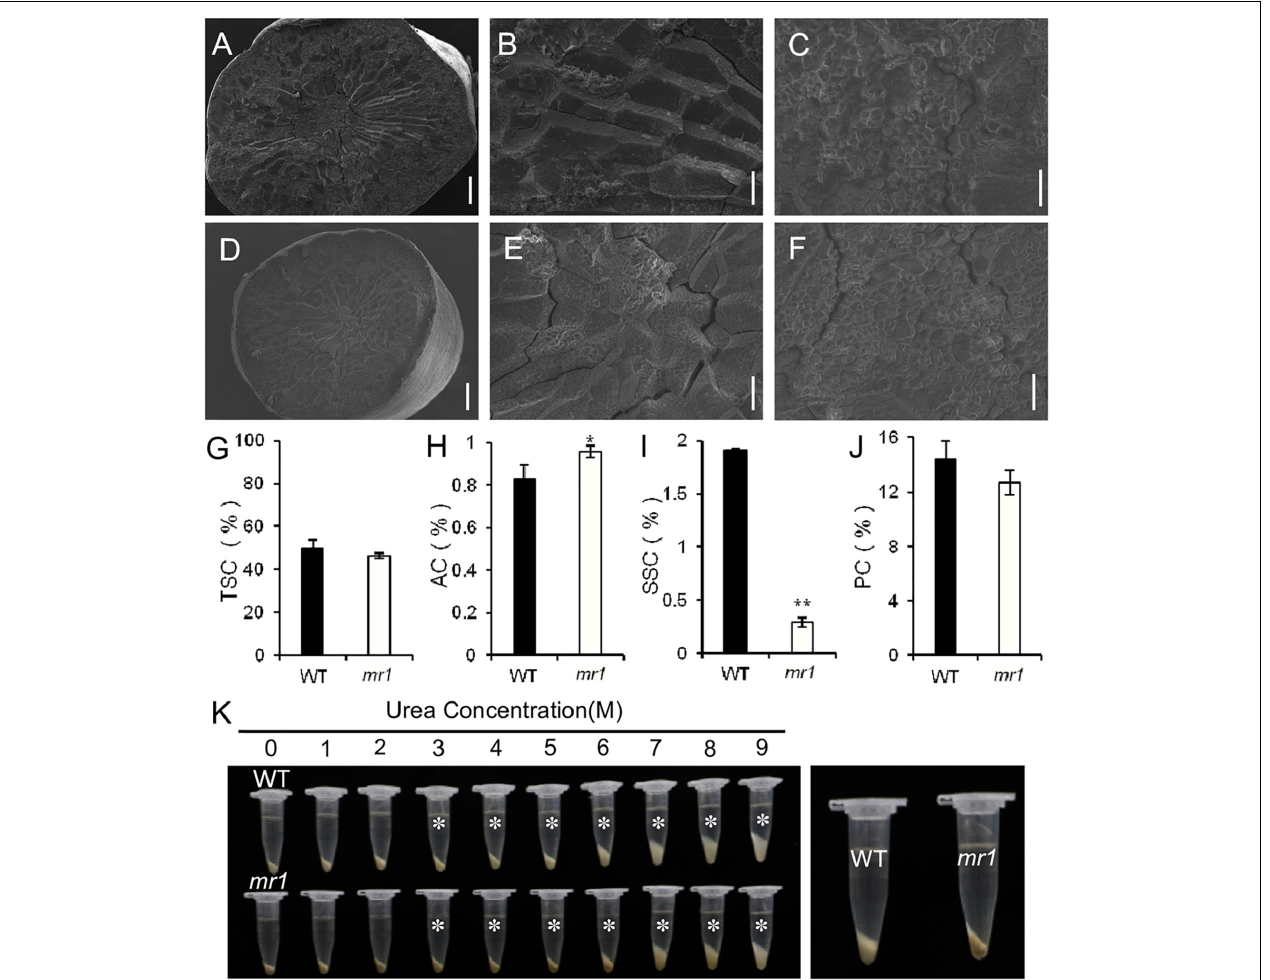
FIGURE 8 | Characteristics of grain and starch in the wild-type and mr1 mutant. (A–F) SEM analysis of transverse sections of brown rice in the wild-type and mr1 mutant. (A–C) Brown rice of the wild-type. (D–F) Brown rice of the mr1 mutant. (G–J) Total starch, amylose, soluble sugar, and protein content in the wild-type and mr1 mutant. (K) Gelatinization characteristics of starch in urea solutions (1–9 M). Asterisks indicate the starch of mr1 endosperm is more difficult to gelatinize in 3–9 M urea solution than that of WT. The most significant difference was observed for 3 M urea (right). Bars, 500 µ m in (A,D) ; 100 µ m in (B,E) ; 20 µ m in (C,F) . *Significant difference at p < 0.05 compared with the wild-type by Student’s t -test. **Significant difference at p < 0.01 compared with the wild-type by Student’s t -test. Error bars indicate